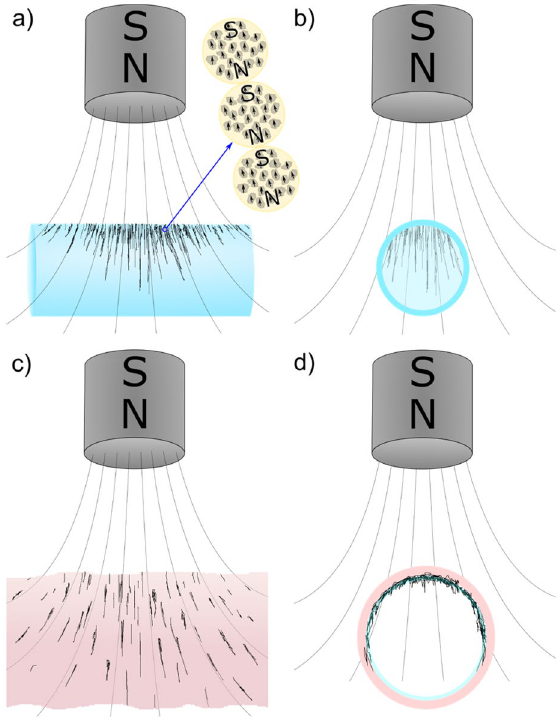
Figure 10. Schematic showing ( a , b ) the creation of particle strings within a fluid filled capillary tube and ( c , d ) an air-filled trachea. Note that the capillary tube and trachea are not drawn to scale. Panel ( a ) also contains a depiction of MP containing Fe 3 O 4 particles arranged into